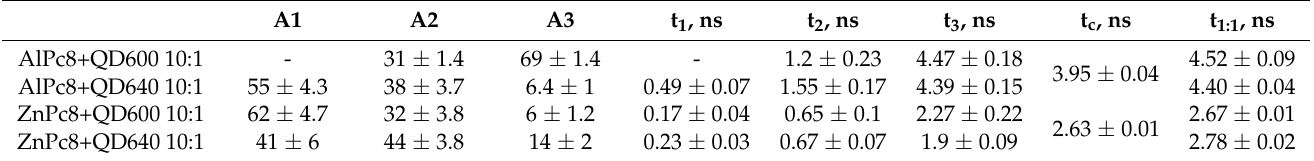
Table 2. Decomposition parameters of the fluorescence decay curves of Pcs in the conjugate with QD600/QD640 with the stoichiometry Pc:QD = 10:1. Fluorescence excitation wavelength is 675 nm. t c is the lifetime of Pc fluorescence in the control without QDs, t 1:1 is the lifetime of Pc fluorescence in the conjugate with QD with stoichiometry